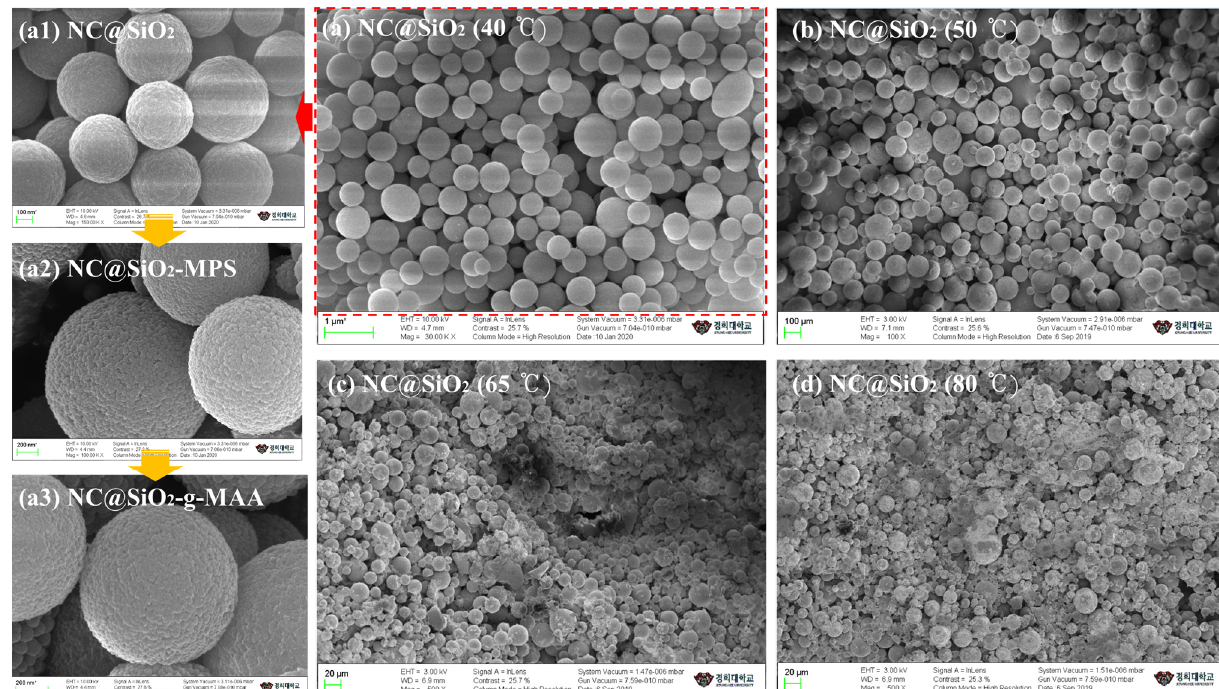
Figure 2. Aspects and shapes of NCs prepared at temperatures from 40 °C to 80 °C; ( a ) NC encapsulation at 40 °C, ( a1 ) NC substrate, ( a2 ) surface composition with MPS, ( a3 ) ligand brush NC (NC@SiO 2 -g-MAA), ( b ) NC encapsulation at 50 °C, ( c ) NC encapsulation at 65 °C, and ( d ) NC encapsulation at 80 °C.